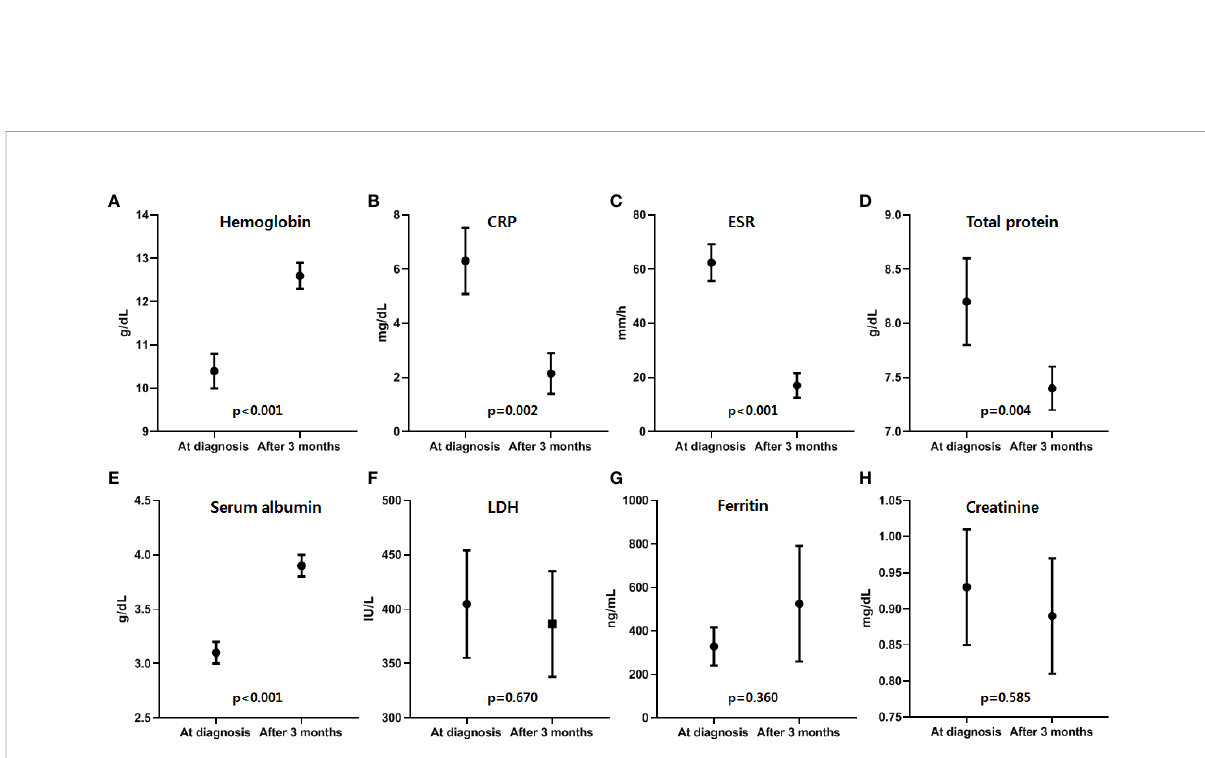
FIGURE 2 Laboratory responses after the fi rst three months of siltuximab treatment. Among the responders, improvements in laboratory parameters, including four laboratory parameters of in fl ammatory response suggested by CDCN guideline 2018, of MCD were observed after a median of 3.2 months (range, 2.8-8.2), and (A) hemoglobin, (B) CRP, (C) ESR, (D) total protein, and (E) albumin levels showed signi fi cant improvement after siltuximab treatment. However, there was no signi fi cant difference in (F) LDH, (G) ferritin, and (H) creatinine levels (Black dots and lines represent the median values and ranges of each parameter). Hb, hemoglobin; CRP, C-reactive protein; ESR, erythrocyte sedimentation rate; LDH, lactate dehydrogenase; CDCN, the Castleman Disease Collaborative Network; MCD, multicentric Castleman disease.